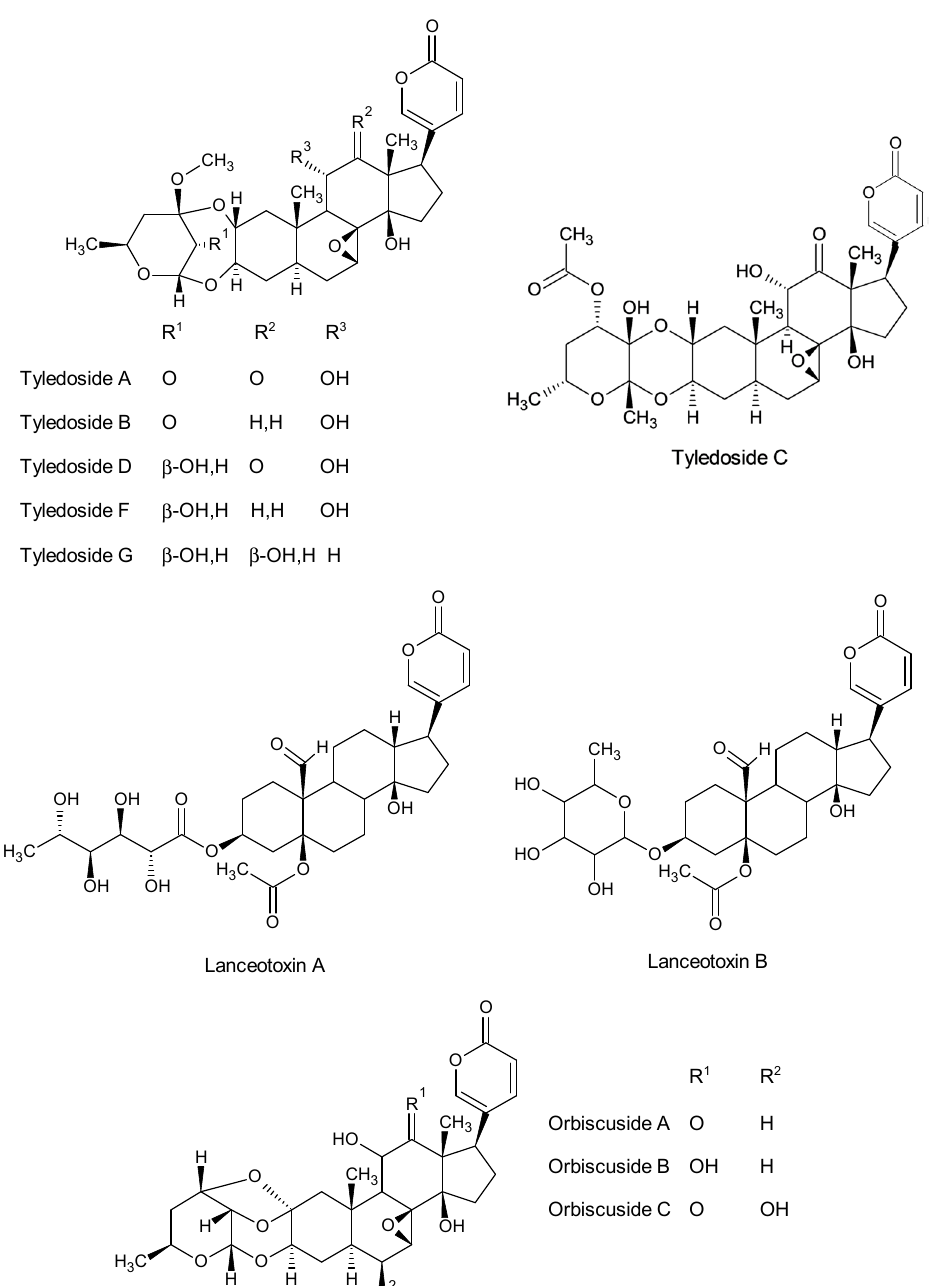
Figure 2. Bufadienolides isolated from poisonous members of the Crassulaceae in South Africa.